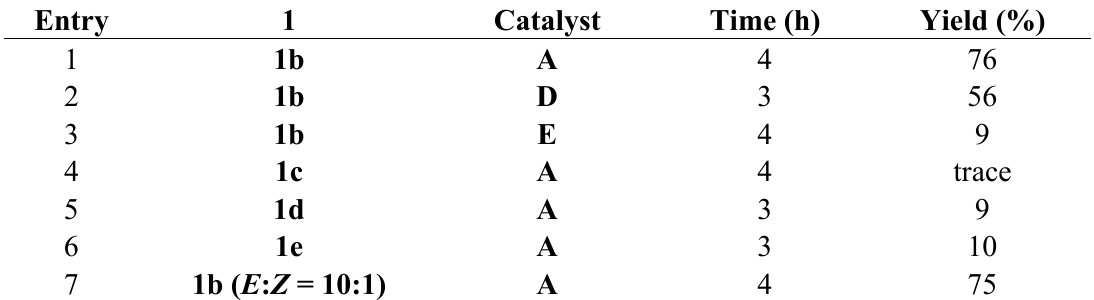
Table 2. CM of Garner aldehyde-derived vinyl glycine equivalents 1b – e with 2